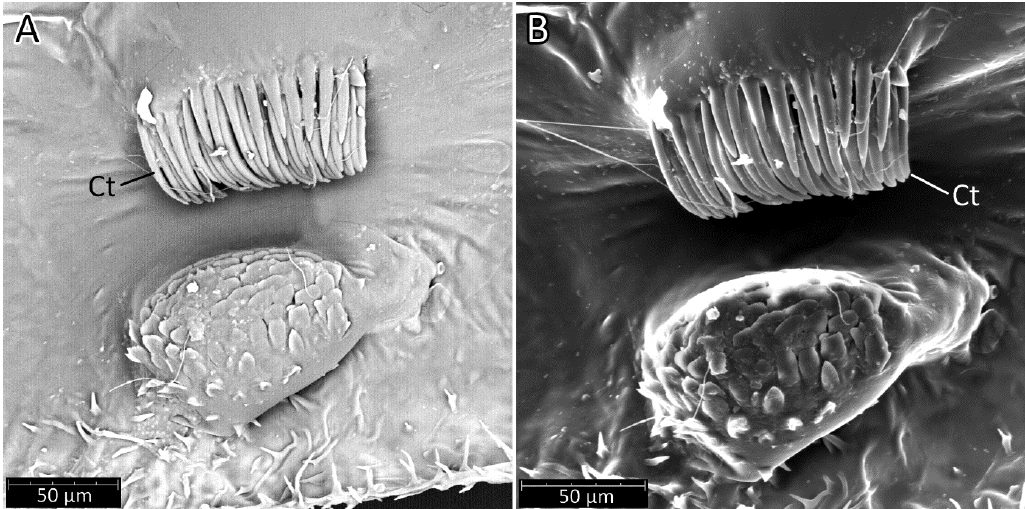
Figure 20. ( A ) Coaptor at the ventral side of the fore wing of Phonoctonus fasciatus (Beauvois, 1805). ( B ) Coaptor using a secondary electron detector (SED). Ct — ctenidia.